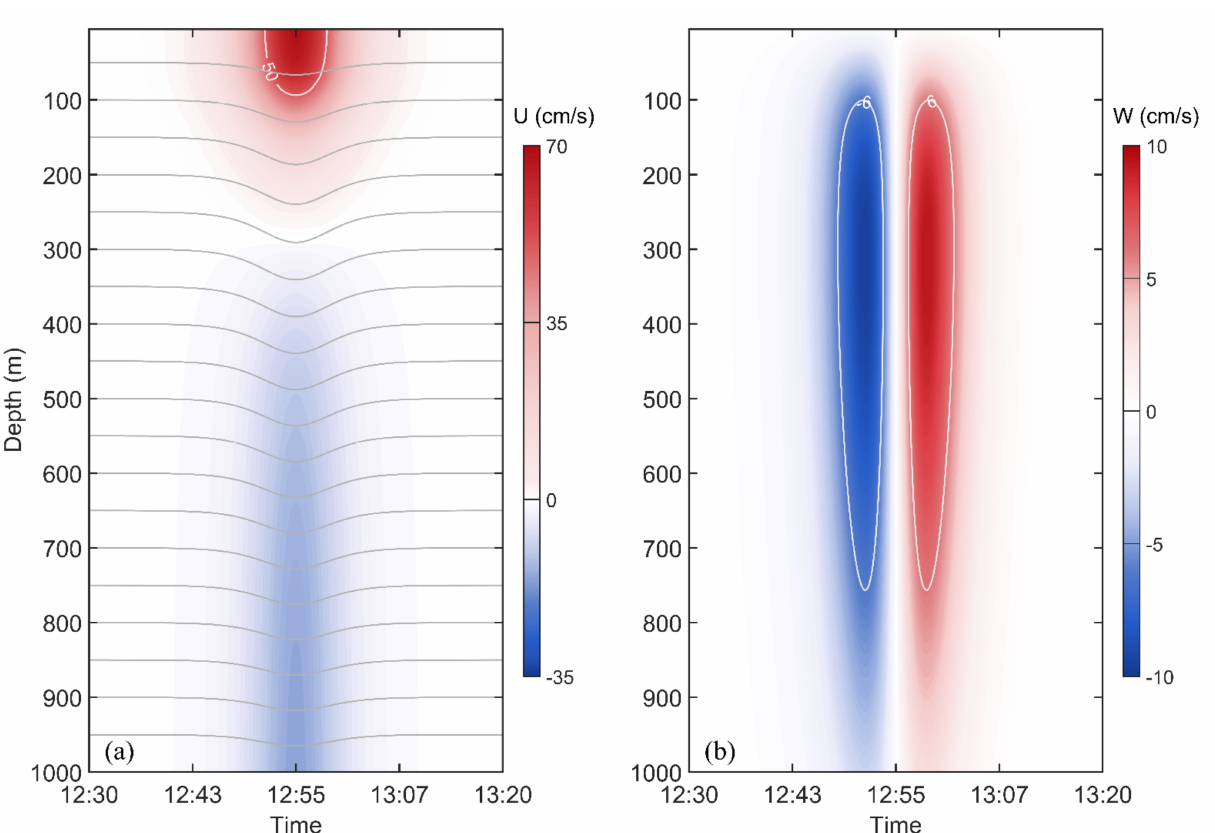
Figure 5. Underwater structure of the ISW. ( a ) Horizontal current along the wave propagation direction. The gray lines are isopycnal. ( b ) Vertical current. The white lines represent 6 cm/s